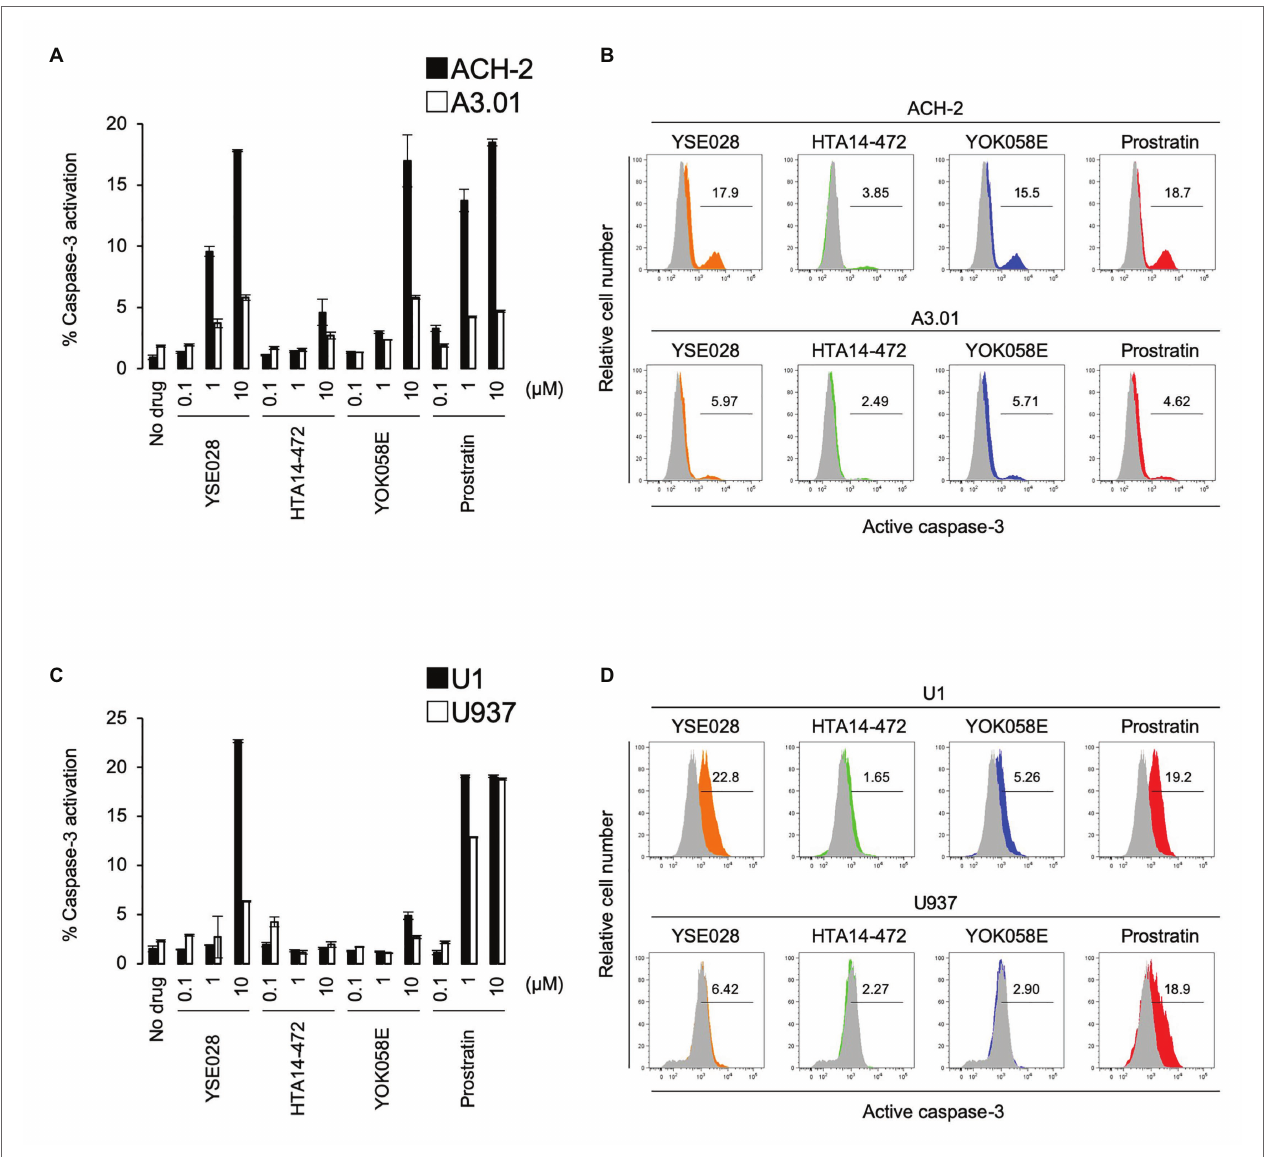
FIGURE 4 | Diacylglycerol-lactone derivatives specifically induce caspase-3 activation in HIV-1 latently infected cells. The active form of caspase-3 was measured by flow cytometry. (A) ACH-2 and A3.01 cells were exposed to different concentrations of DAG-lactone derivatives and prostratin for 24 h. (B) The histogram shows representative data for caspase-3 activation with exposure to 10 μ M reagent in ACH-2 and A3.01 cells. (C) U1 and U937 cells were exposed to different concentrations of DAG-lactone derivatives and prostratin for 24 h. (D) The histogram shows representative data for caspase-3 activation with exposure to 10 μ M reagent in U1 and U937 cells. Data are shown as means ± SDs of three independent